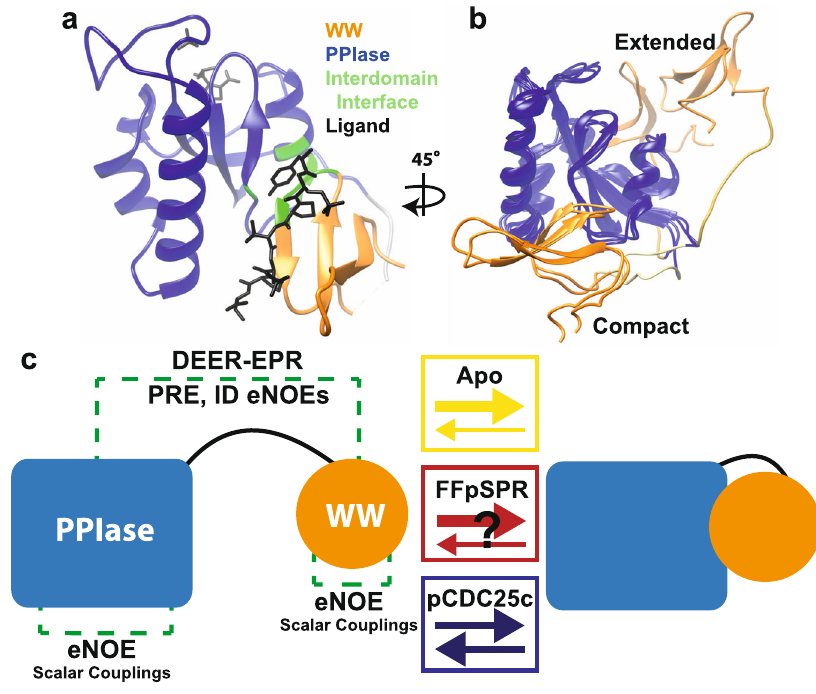
Fig. 1 | Multiple conformations in Pin1. a Crystal structure 1PIN 17 overlaid with C-terminal domain peptide from crystal structure 1F8A 11 . PPIase domain, WW domain, interdomain interface and ligand are shown in blue, orange, green and